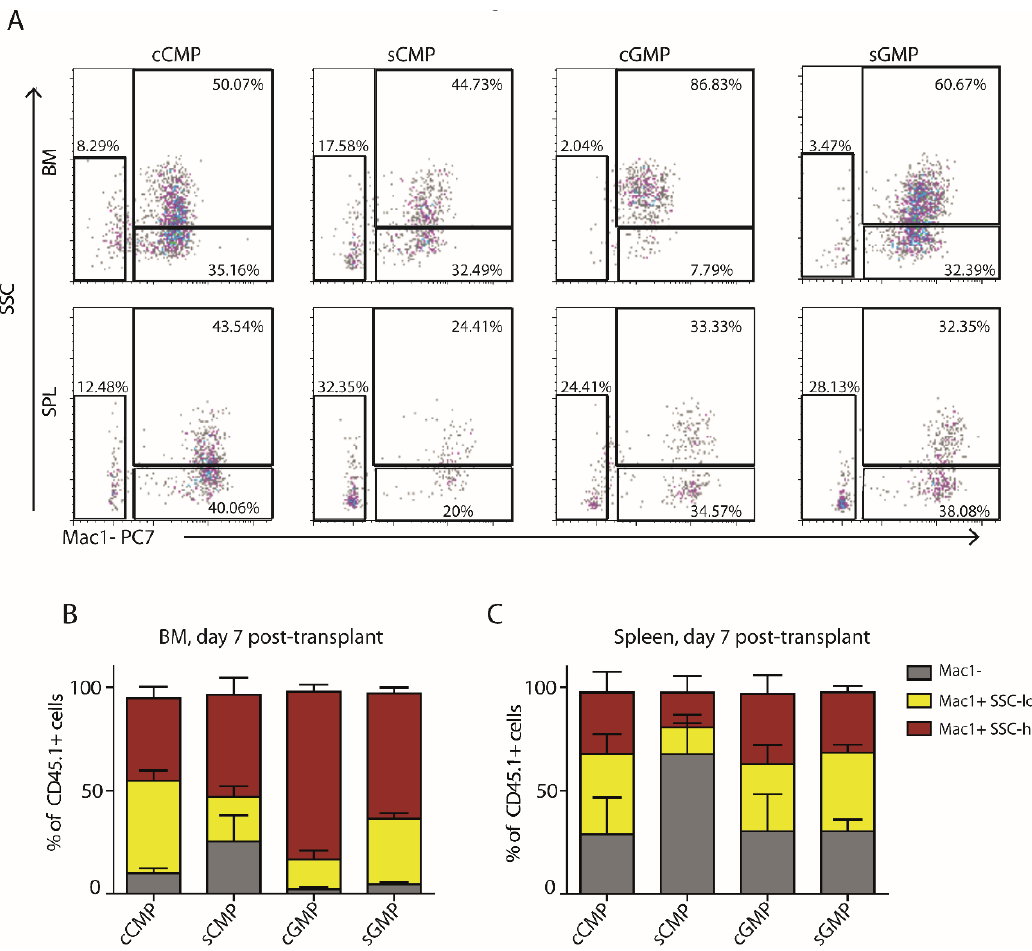
Figure 4. Transplantation of CD34/CD150 or CD34/Fc γ R sub-populations yields comparable progeny in vivo. Myeloid progenitor sub-populations sorted from CD45.1 donors by CD34/Fc γ R or by CD34/CD150 and transplanted into non-irradiated CD45.2 congenic recipients. Spleens and BM from tibiae and femur were harvested seven days later, and FACS analyzed. ( A ) Representative plots showing surface expression of Mac-1/Side-Scatter (SSC) of CD45.1 donor-derived cells. ( B – C ) Histograms summarizing frequencies of the differentiated myeloid progeny in the BM ( B ) and spleen (C) . Graphs represent data from n = 4 independent experiments.